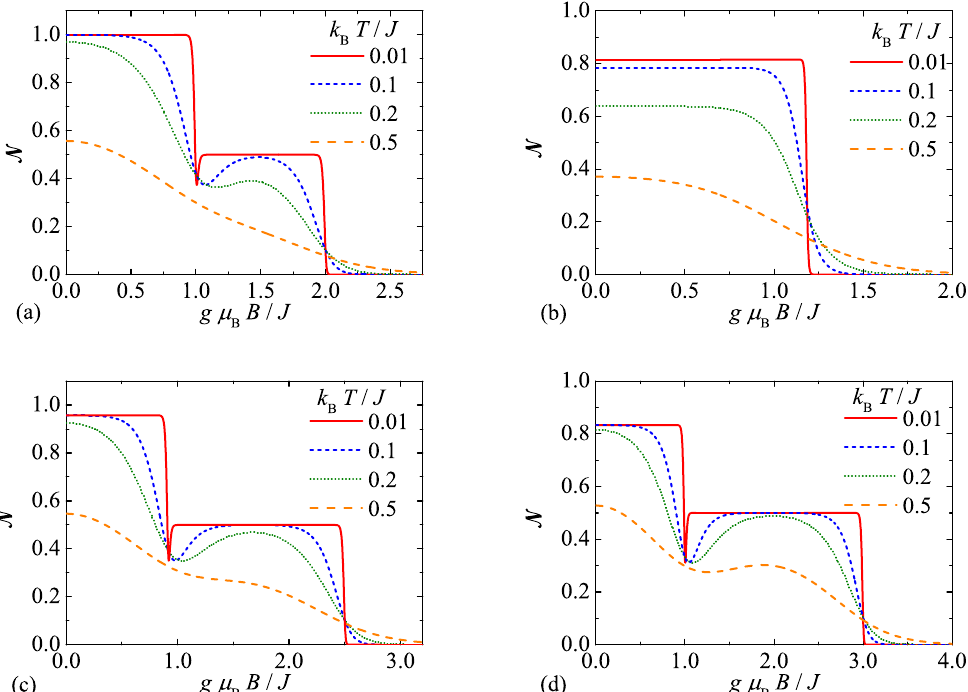
Figure 2. The negativity of the spin-1 Heisenberg dimer as a function of the magnetic field for the particular case with the isotropic exchange coupling ∆ = 1, a few selected values of temperature (see legend) and four different values of the uniaxial single-ion anisotropy: ( a ) D / J = 0.0; ( b ) D / J = − 2.0; ( c ) D / J = 0.5; ( d ) D / J =